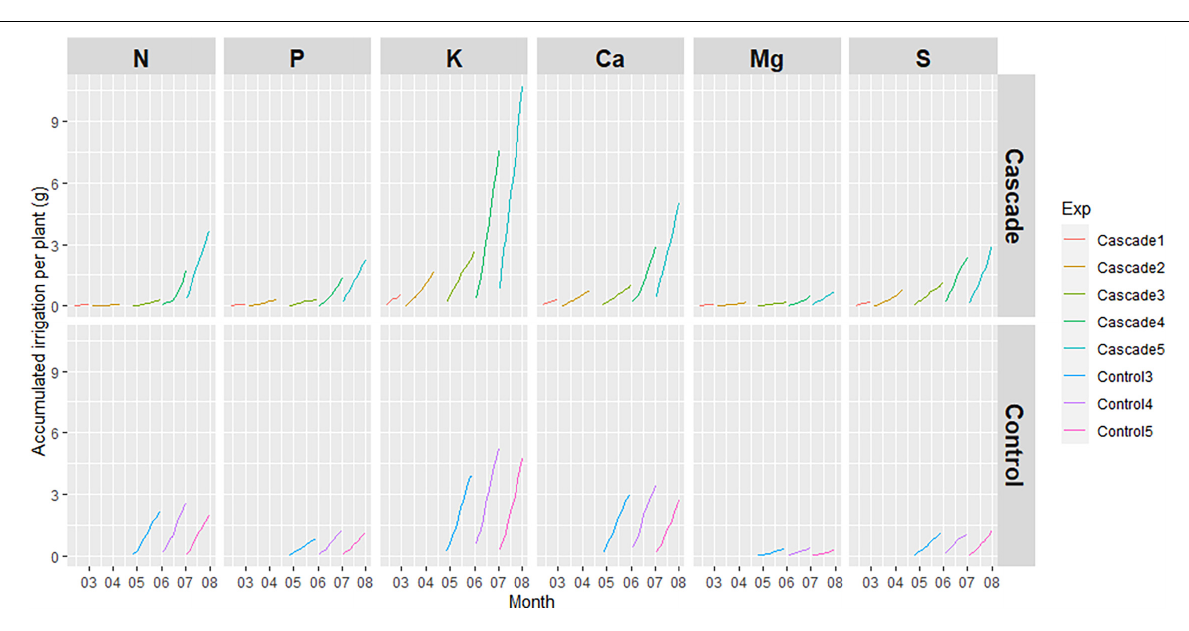
FIGURE 5 | Accumulated irrigated nutrients per plant per